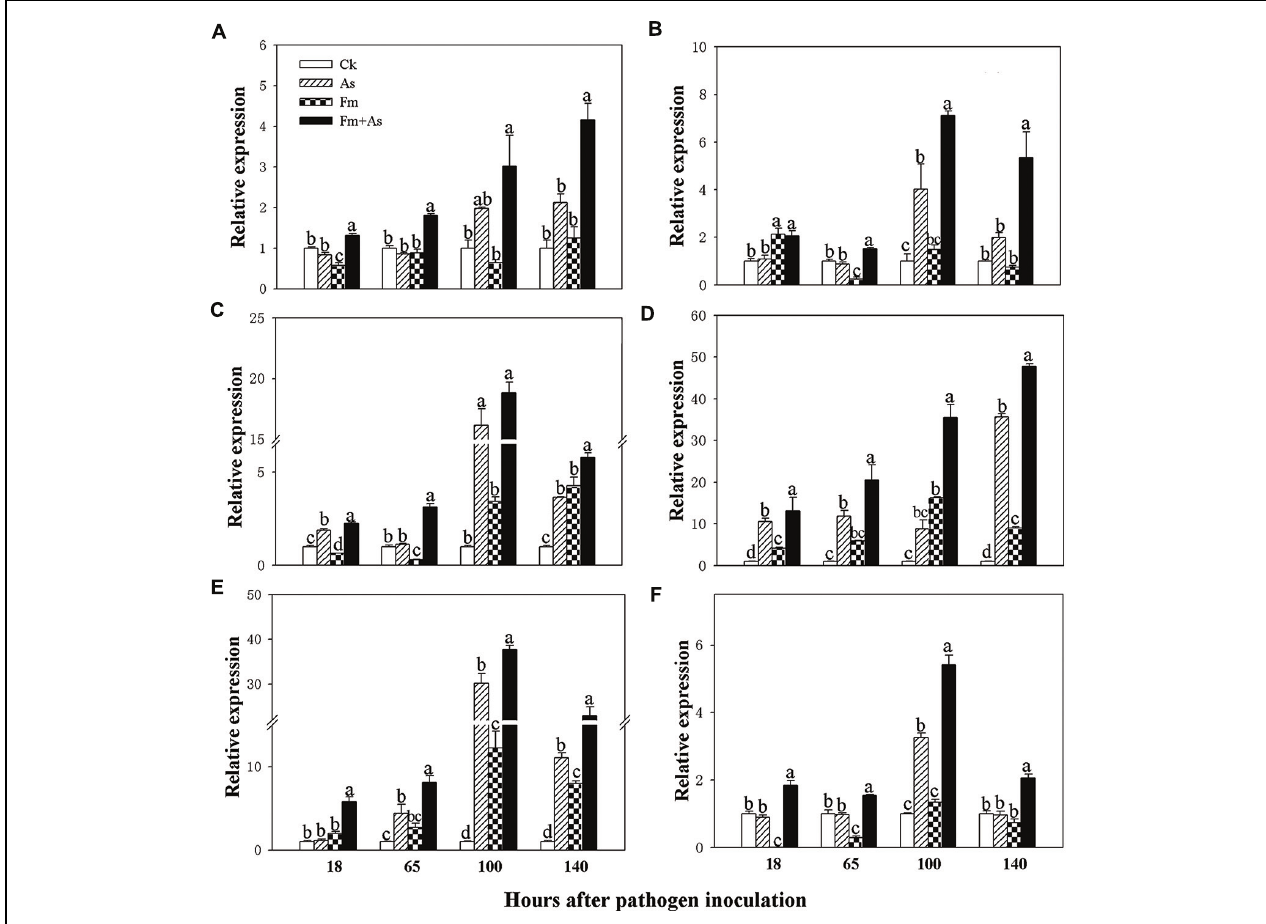
FIGURE 3 | Transcripts of defense-related genes in tomato leaves in response to mycorrhizal colonization and pathogen infection. The tomates were pre-inoculated with mycorrhizal fungus Funneliformis mosseae and later inoculated with A. solani , the causal agent of early blight disease of tomato. Quantitative real time RT-PCR was used to detect the transcripts of six defense-related genes encoding PAL (A) , LOX (B) , allene oxide cyclase ( AOC ) (C) , pathogen-related proteins ( PR1 ) (D) , β -1,3-glucanase (basic type PR-2 ) (E) , and chitinase ( PR-3 ) (F) . Four treatments included: (1) CK: control plants without pathogen and mycorrhizal inoculation; (2) As: plants inoculated with A . solani only; (3) Fm: plants inoculated with F. mosseae only; (4) Fm + As: plants inoculated with both F. mosseae and A . solani . Values are means ± SE from three sets of independent experiments with three pots per treatment for each set of experiments. Significant differences ( P < 0.05 using Tukey post hoc test) among treatments in a group are indicated by different letters above